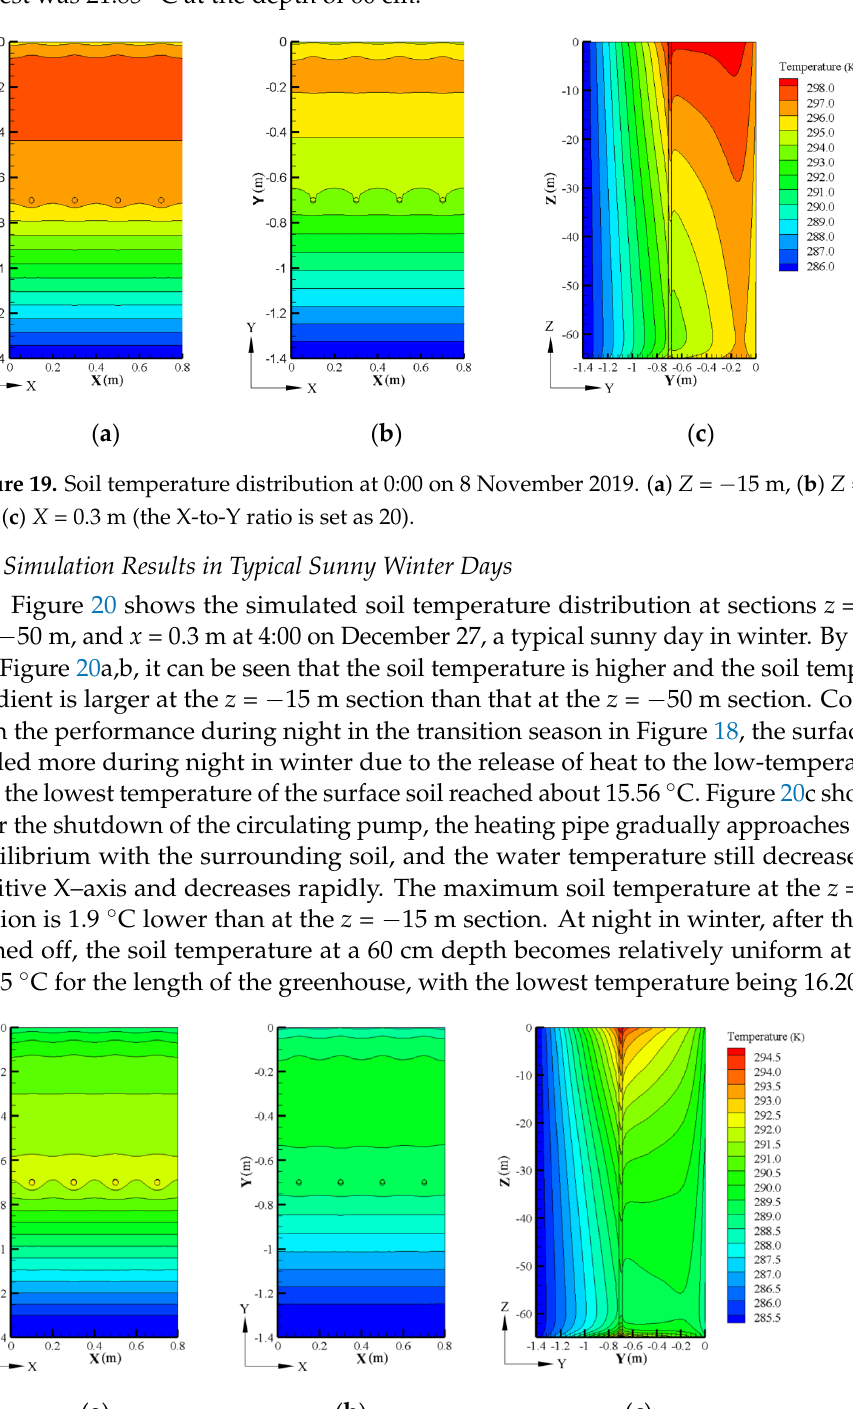
( c ) Figure 18. Simulated soil temperature distribution at 0:00 on 24 October 2019. ( a ) Z = − 15 m, ( b ) Z = − 50 m, and ( c ) X = 0.3 m (the X-to-Y ratio is set as 20). By comparing Figure 18a,b, it can be seen that, under the combined action of solar radiation and upward heat flow from the fluid in the heating pipe, the soil temperature gradient above the heating pipe increases along positive X–axis. The variation in soil tem- perature gradient below the heating pipes is small and the isotherms are denser, revealing that heating pipes have a limited influence on the soil below them.